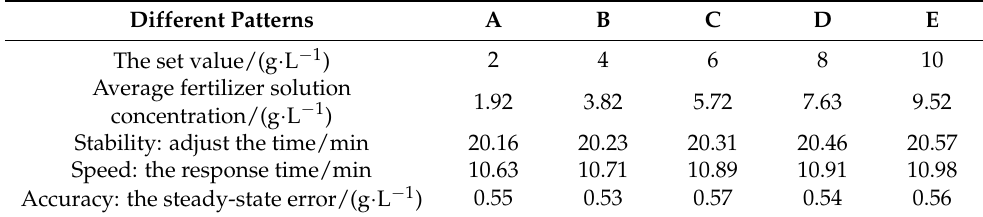
Table 4. Performance indices of the mixed application control